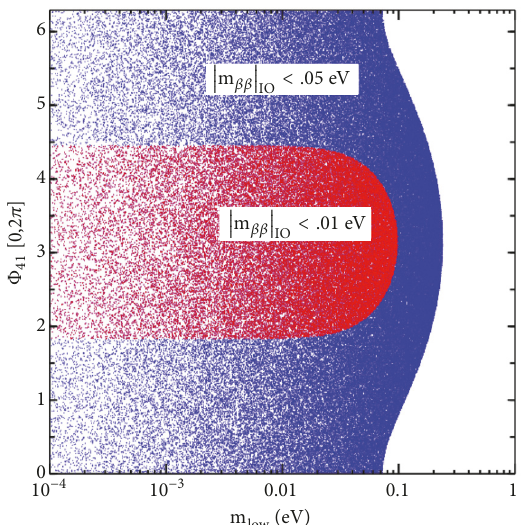
Figure 4: Regions in the (𝑚 𝑙𝑜𝑤 , 𝜙 21 ) plane where two different conditions on |𝑚 𝛽𝛽 | 𝐼𝑂 apply. In the blue region |𝑚 𝛽𝛽 | 𝐼𝑂 satisfies |𝑚 | < .05𝑒𝑉 and red region satisfies |𝑚 𝛽𝛽 𝐼𝑂 values of 𝜃 𝑘𝑙 , 𝛿𝜇 2 𝑗𝑘 , and 𝜙 󸀠 31 from the corresponding 2𝜎 intervals of oscillation